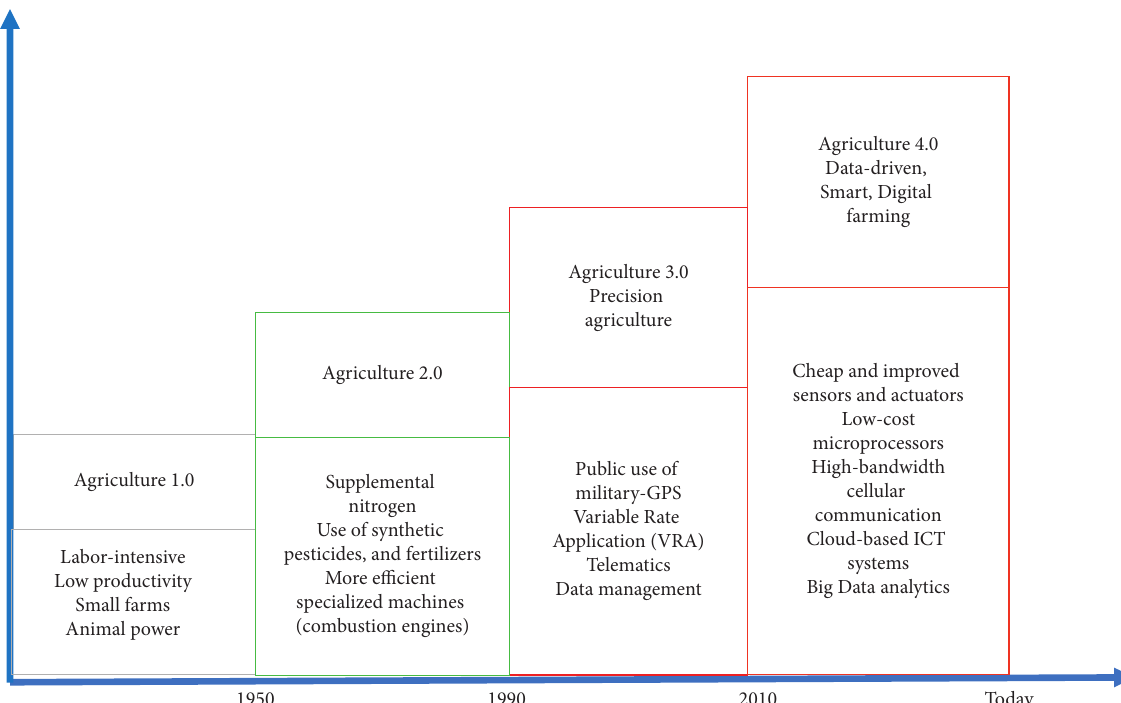
Figure 4: Paradigm shifts in